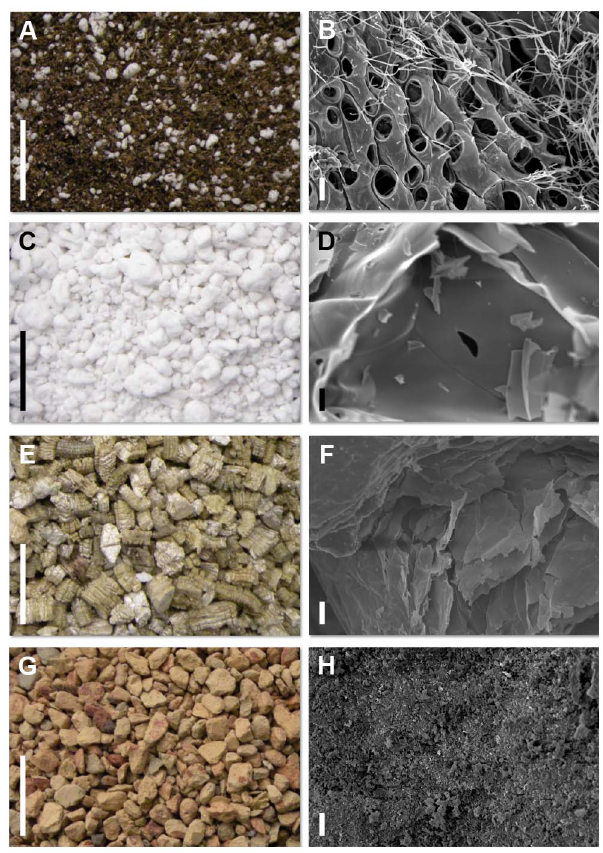
Figure 2. Photographic and SEM images of various media substrates. (A–B) peat germinating mix, (C–D) perlite. (E–F) vermiculite. (G–H) Turface. (A,C,E,G) Photographic images exhibiting textural differences between media substrates. (B,D,F,H) Scanning election microscopy photos of substrates. Scale Bar (A,C,E,H) 1 cm and (B,D,F,H) 10 m